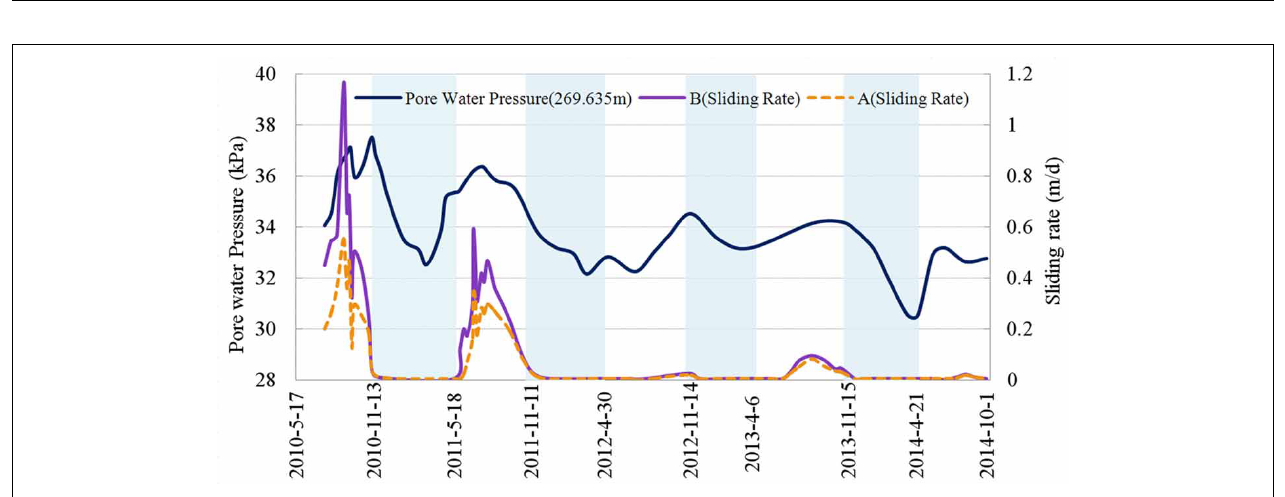
FIGURE 12 | Daily precipitation and pore water pressure in the depth of 19.4cm of D point in K178 + 530 section of Bei’an-Heihe Highway.